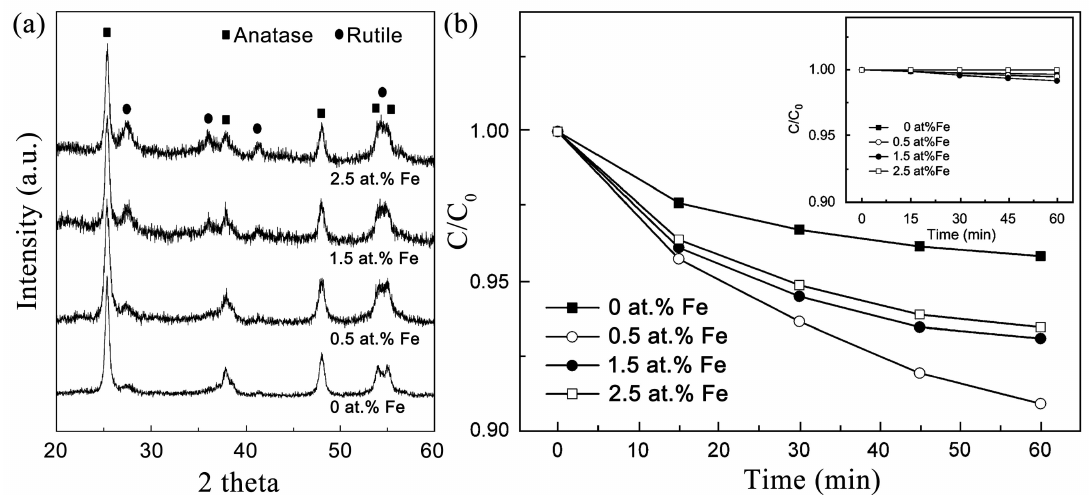
Figure 5. XRD results of Fe 3+ -doped TiO 2 /SnO 2 nanofibers with different Fe content ( a ), and the degradation of RhB dye under visible light irradiation ( b ). Inset shows the adsorption of RhB on hybrid nanofibers. (Redrawn with the permission of Ref. [57]. Copyright 2010 John Wiley and Sons).